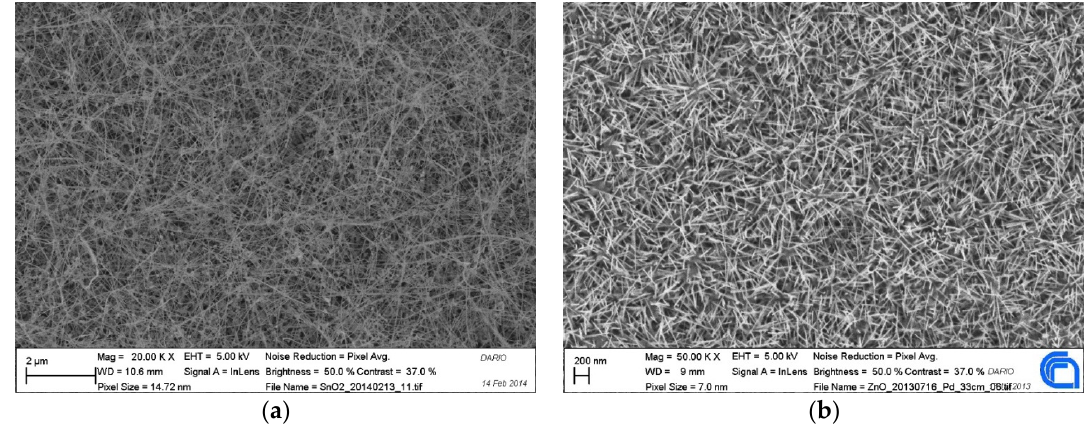
Figure 5. Nanowire ( a ) SnO 2 ; and ( b ) ZnO SEM images.